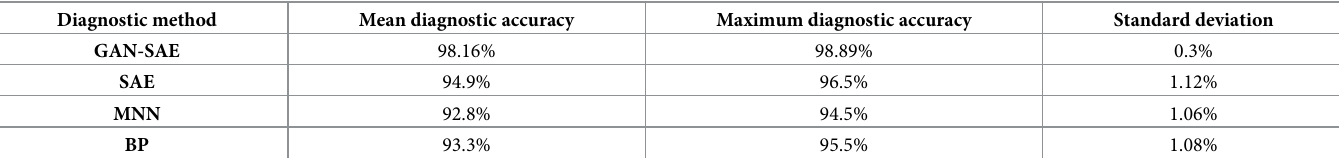
Table 6. Comparison diagnostic accuracy of different methods.